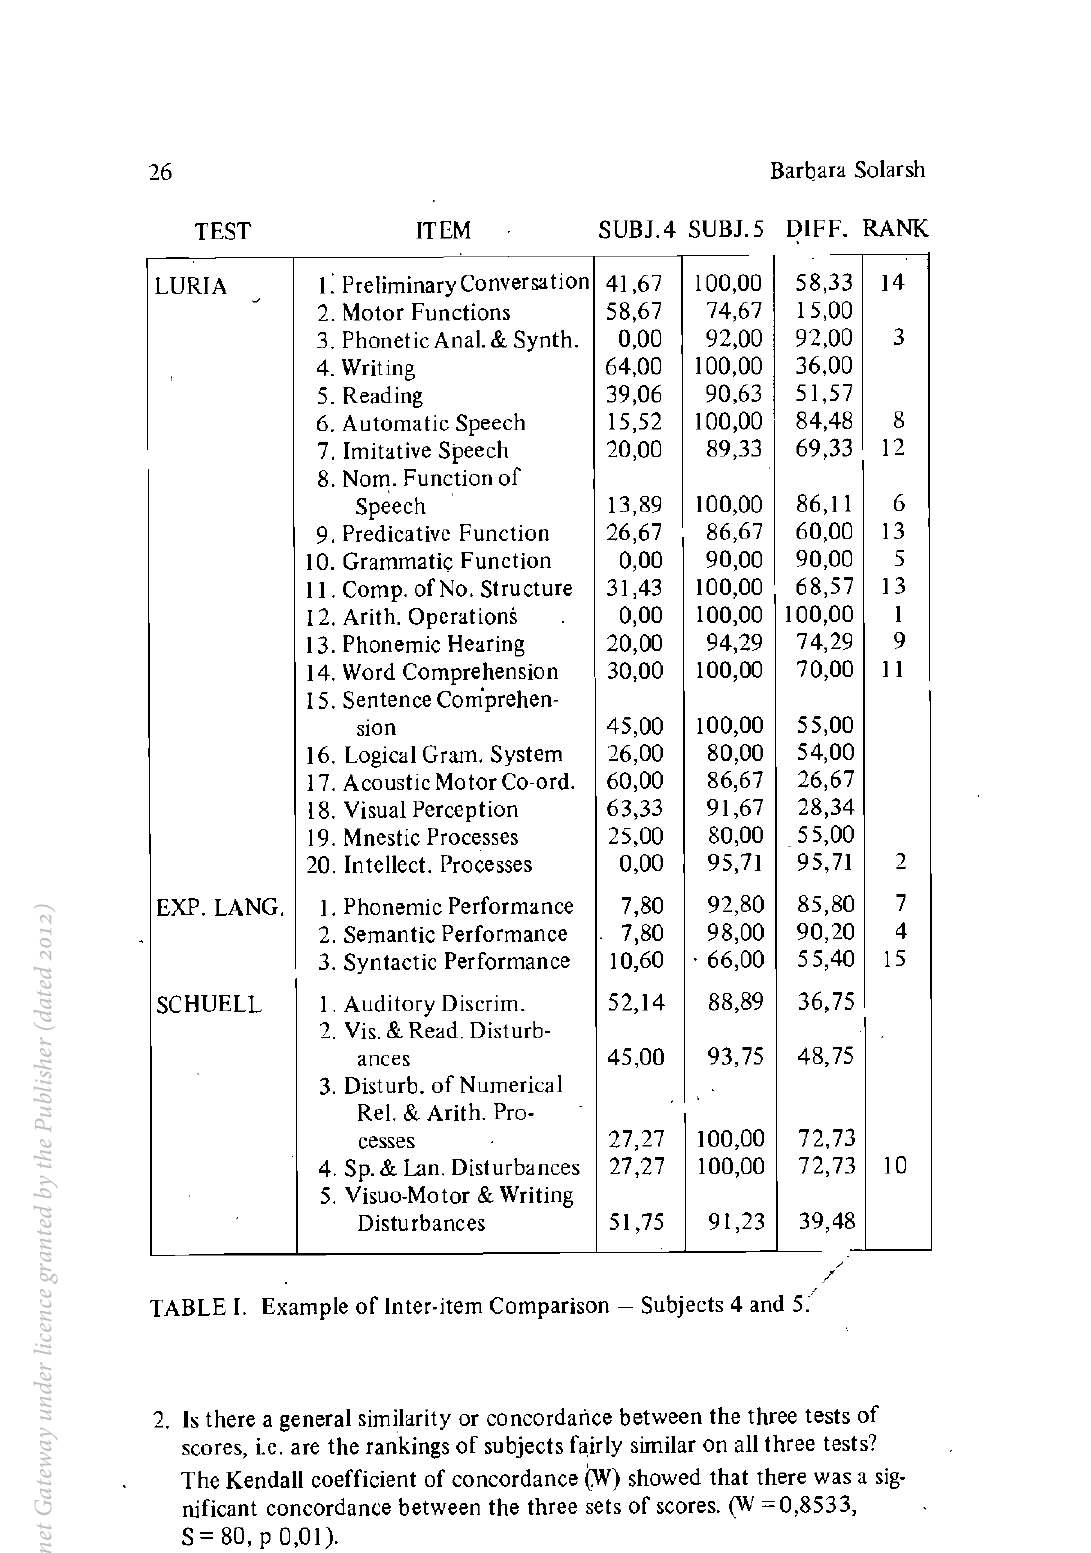
2. Is there a general similarity or concordance between the three tests of scores, i.e. are the rankings of subjects fairly similar on all three tests? The Kendall coefficient of concordance (\V) showed that there was a sig- nificant concordance between the three sets of scores. (W =0,8533, S = 80, ρ